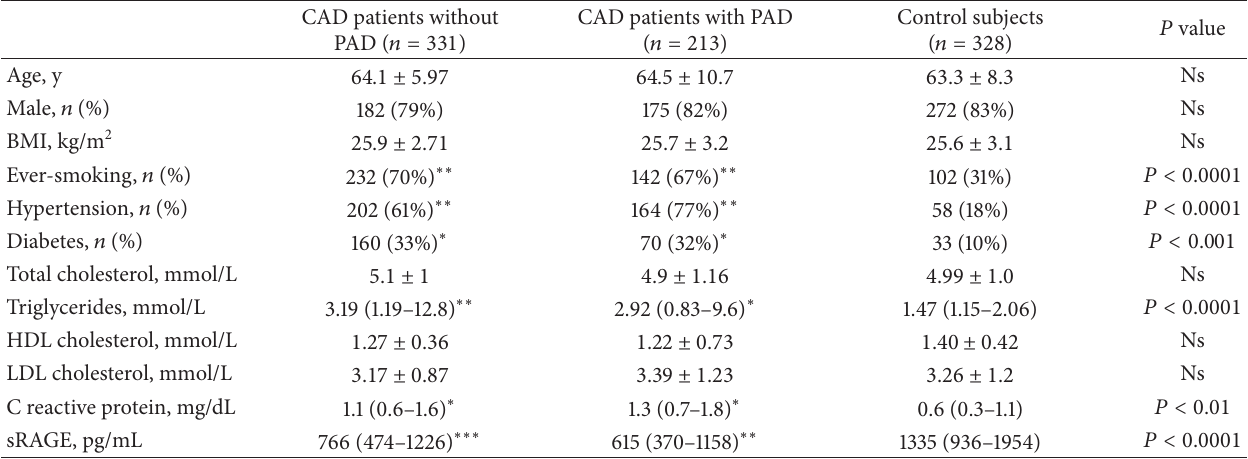
Table 1: Clinical characteristics and laboratory parameters of CAD patients with and without PAD and control subjects.